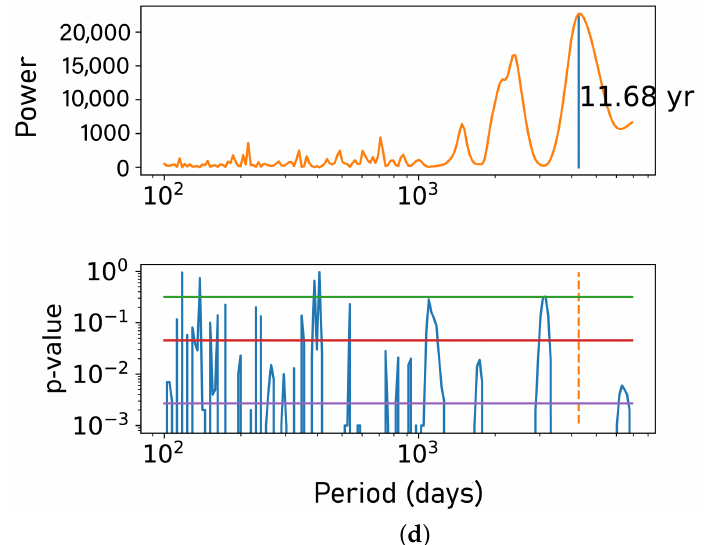
Figure 5. Panel ( a ) depicts the TSI data (green) and the smoothing line (red). Panel ( b ) depicts the light curve after subtracting the smoothing line (the smoothed light curve), and the two horizontal lines represent the 3-sigma range. Panel ( c ) depicts the residual between the summed number of outliers and the linear model representing constant magnetic activity. Panel ( d ) (a pair plots) contains the power spectrum and the p -values of panel ( c ). The green, red, and purple horizontal lines show the 1-sigma, 2-sigma, and 3-sigma uncertainty, respectively. The strongest cycle is marked in panel ( d